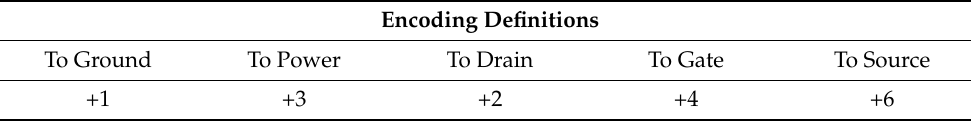
Table 1. Definitions of transistor encoding.